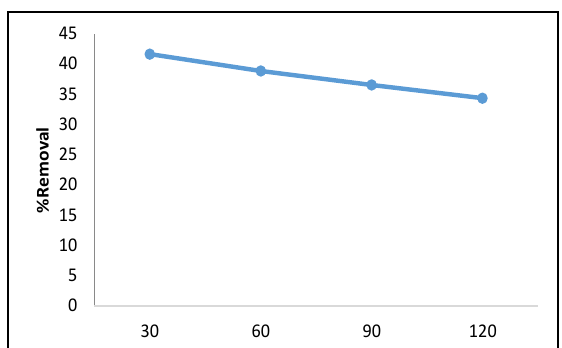
Fig. 6. The removal efficiency of Cr (VI) by ferrous sulfate at different pH values